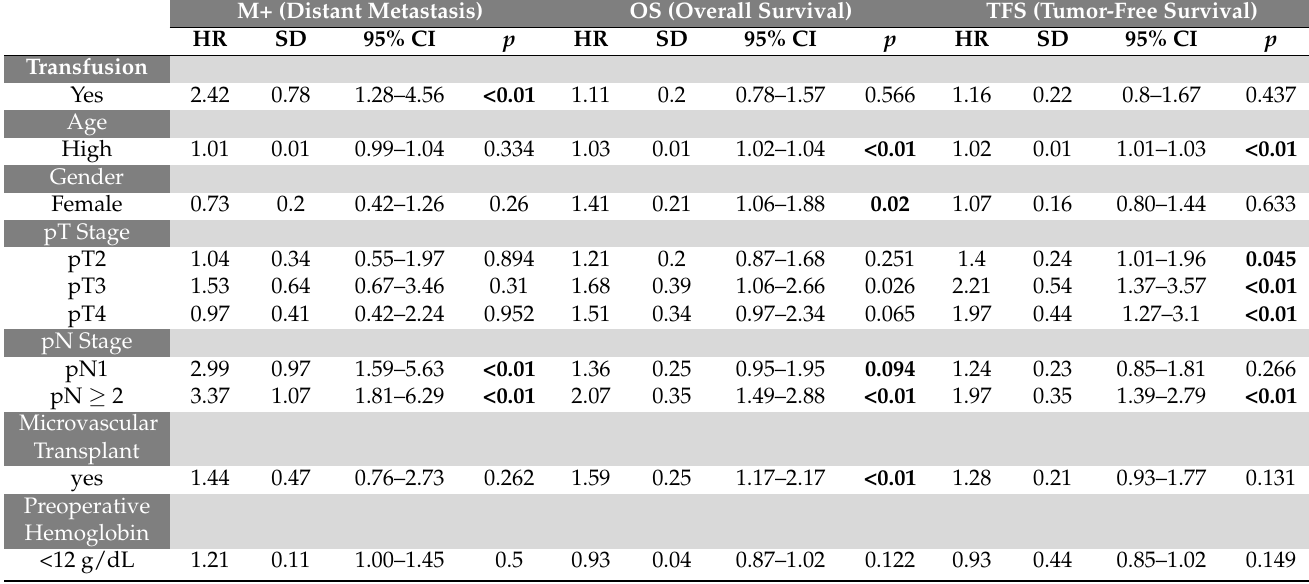
Table 3. Multivariate Cox regression analysis of the correlation of the transfusion status and the outcome parameters M+, OS, and TFS adjusted for age, gender, pT-, pN-classification, use of mi- crovascular transplant, and preoperative hemoglobin